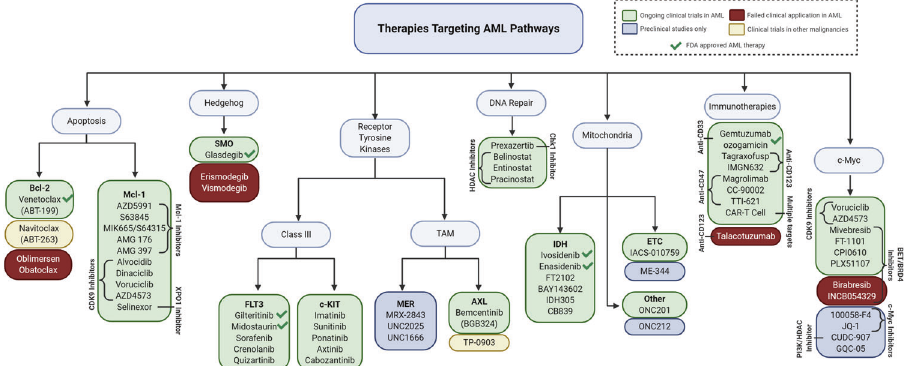
Fig. 7 Therapies targeting AML pathways. Summary of newly approved therapeutics, therapeutics currently under clinical investigations, preclinical therapies, and failed clinical therapies in